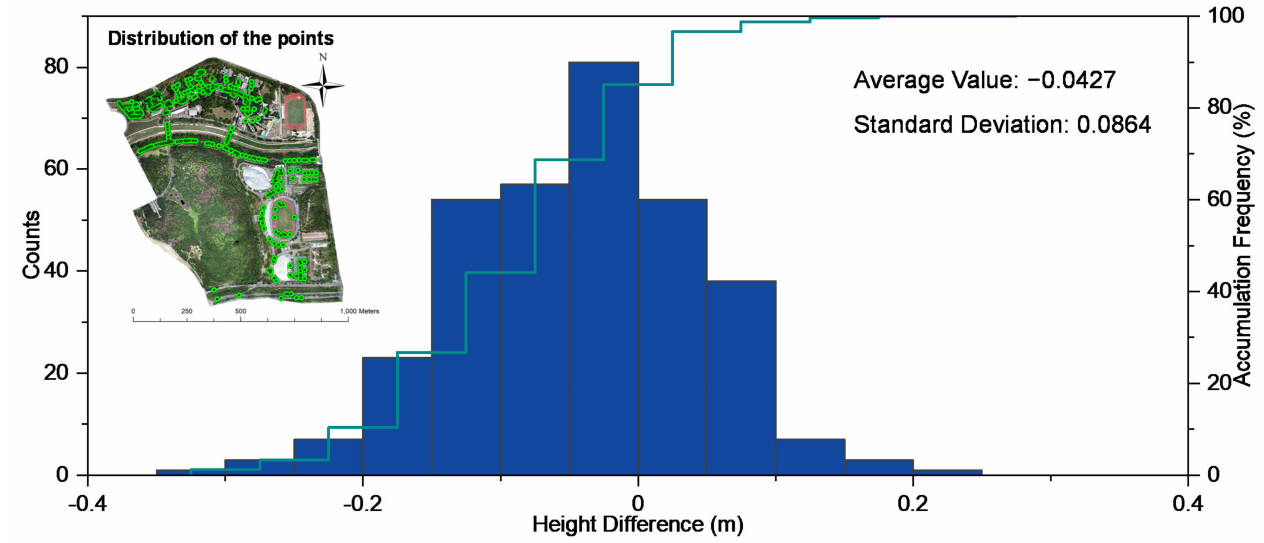
Figure 2. Height differences of 330 points, distributed across roads and building roofs before and after the